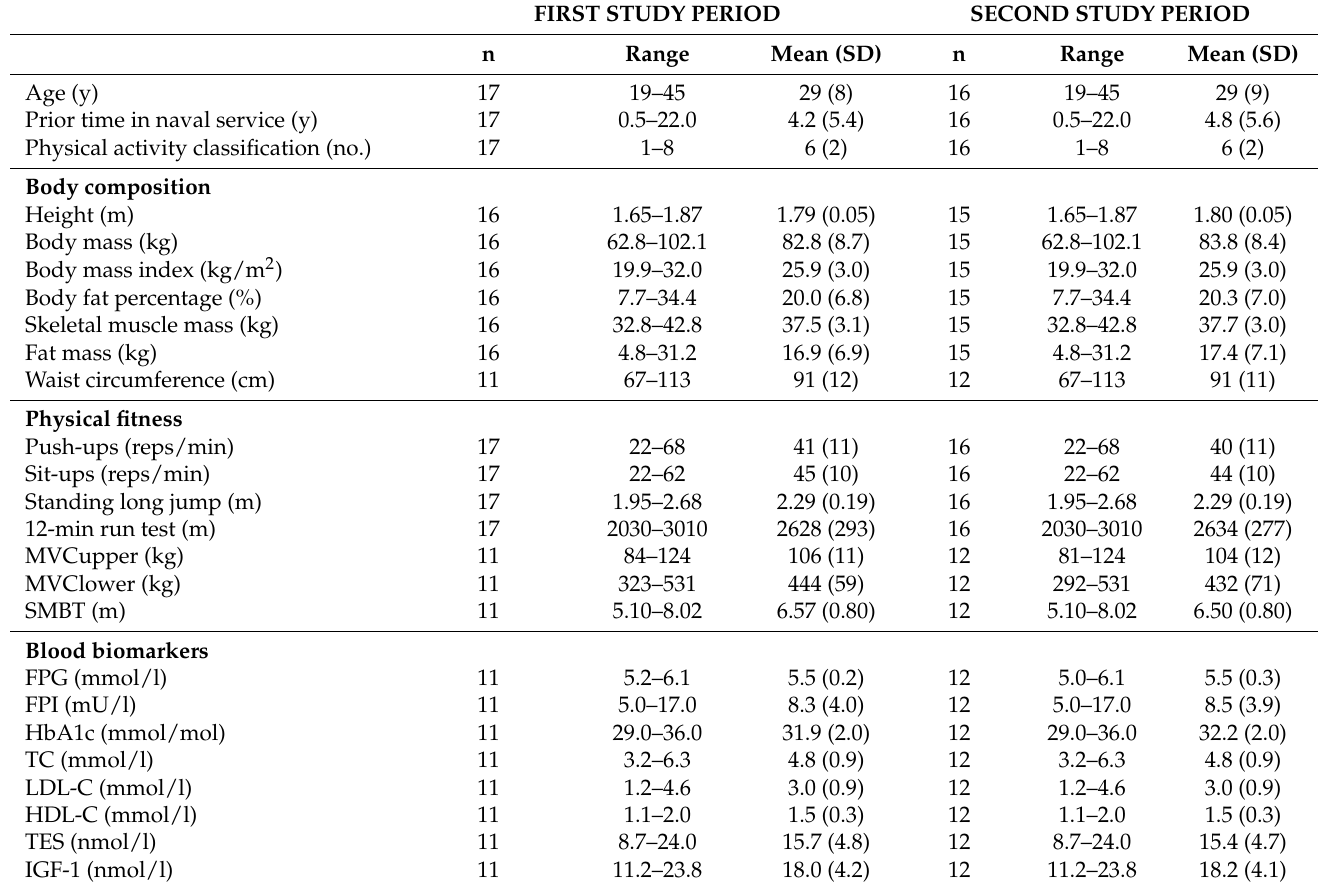
Table 1. Description of the individual characteristics of the study participants. Range, mean and standard deviation (SD) are